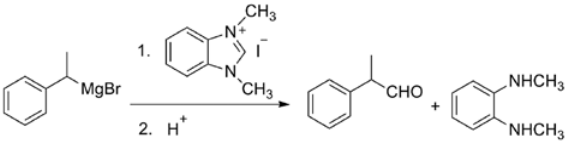
Scheme 2: Synthesizing hydratropic aldehyde from benzimidazo- lium salt and Grignard